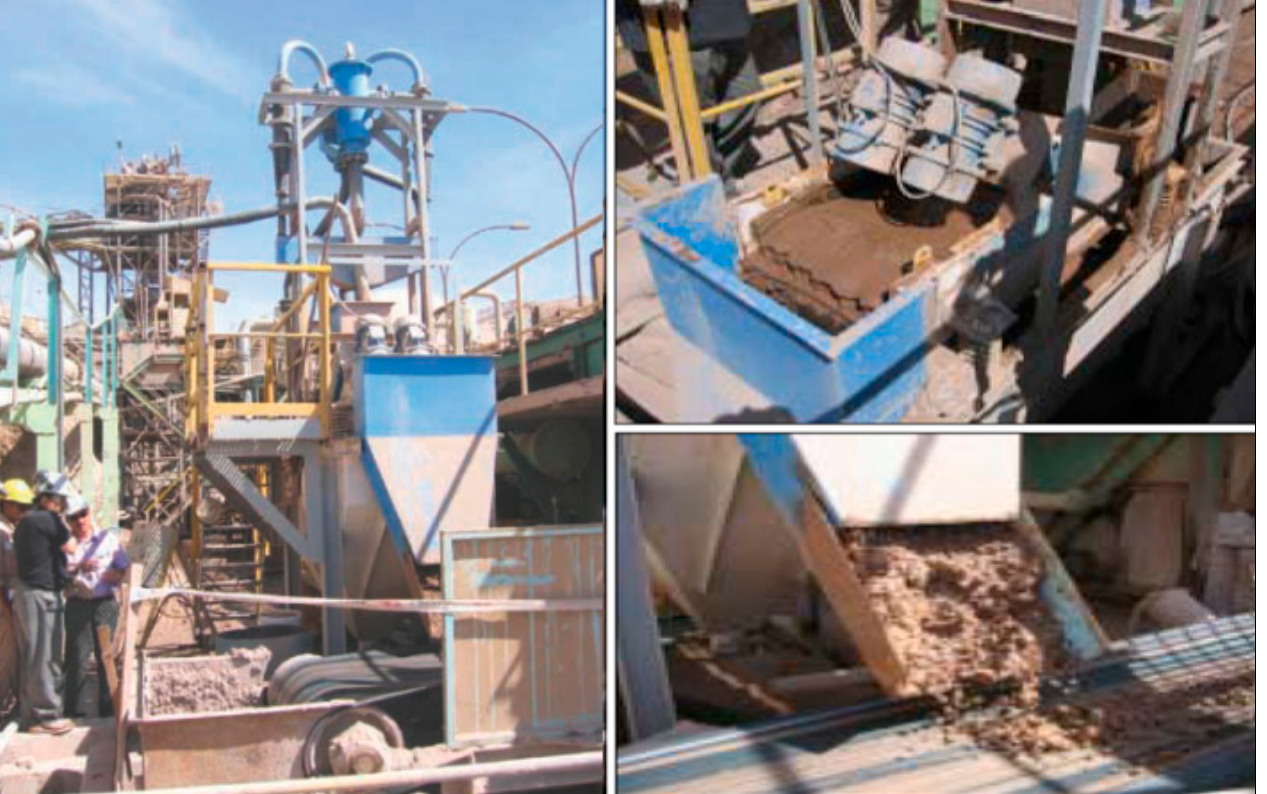
Figure 5. Dewatering Pilot Plant 600 mtpd: Hydrocyclone + Horizontal Vibratory Dewatering Screens Overview–Horizontal Vibratory Screens Operation–Cake Tailings Product [34].